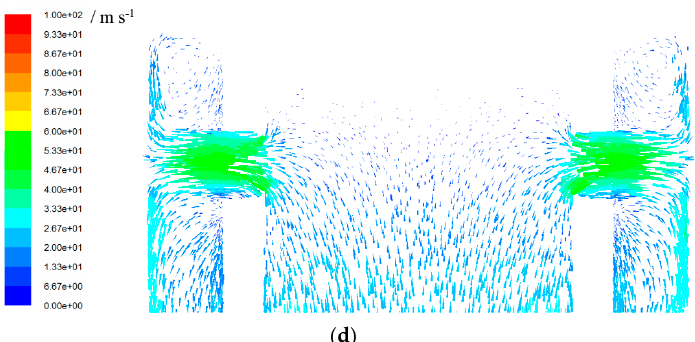
Figure 14. Inner tube orifices outlet velocity vector of nozzle A and nozzle B. ( a ) nozzle A (100% load); ( b ) nozzle B (100% load); ( c ) nozzle A (30% load); ( d ) nozzle B (30% load).